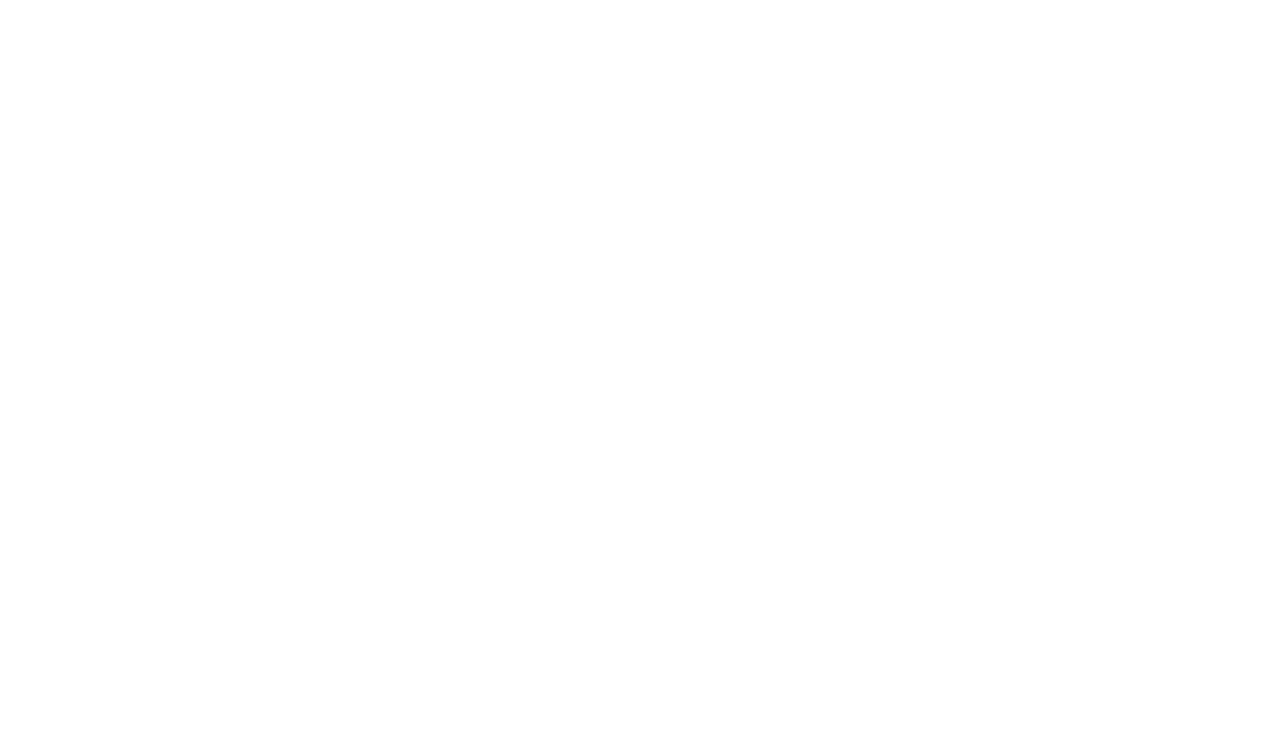
FIGUREA1 | Collector’s curves for the Chao1 richness estimator and Shannon diversity index for two different OTU-picking methods. These